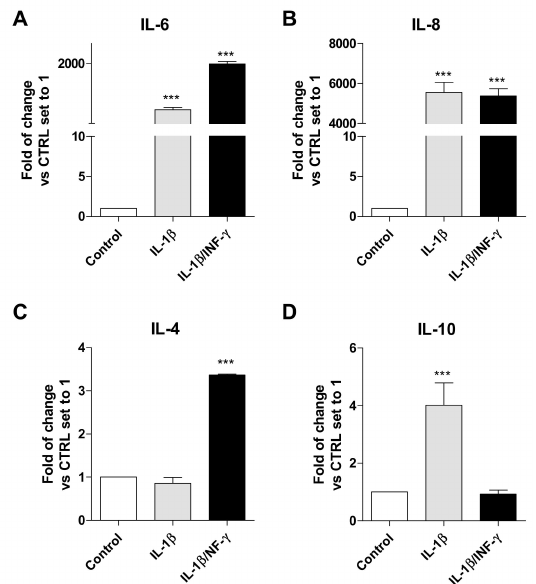
Figure 1. Interleukin production by C20 cells as an inflamed model of human microglia. The mRNA levels of the pro-inflammatory interleukins IL-6 and IL-8 ( A , B ) and the anti-inflammatory interleukins IL-4 and IL-10 ( C , D ) were monitored in C20 cells following IL-1 β (20 ng / mL, grey bars) and IL1- β / INF- γ (100 ng / mL / 50 ng / mL black bars) treatment for 24 h. The data are expressed as the fold of change versus the control, which was set to 1, and are presented as the mean values ± SEM of two independent experiments performed in duplicate. The significance of the di ff erences was determined by one-way ANOVA, which was followed by Bonferroni’s post-test: *** p ≤ 0.001, vs. control.